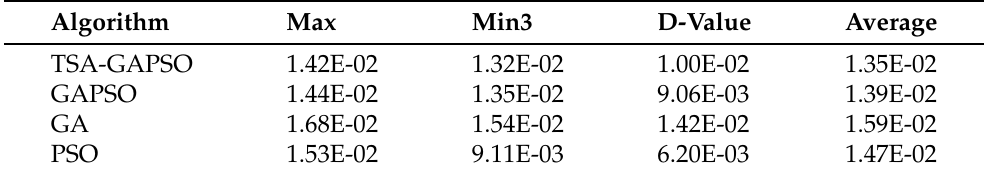
Table 1. The algorithm statistics index data of mine water dispatching model.